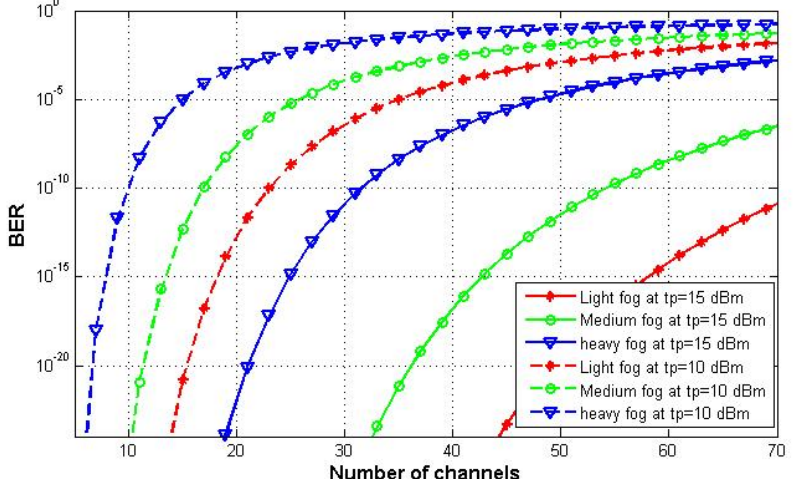
Figure 5. BER of FSO-PDM/PV-OCDMA system versus number of channels under foggy conditions.